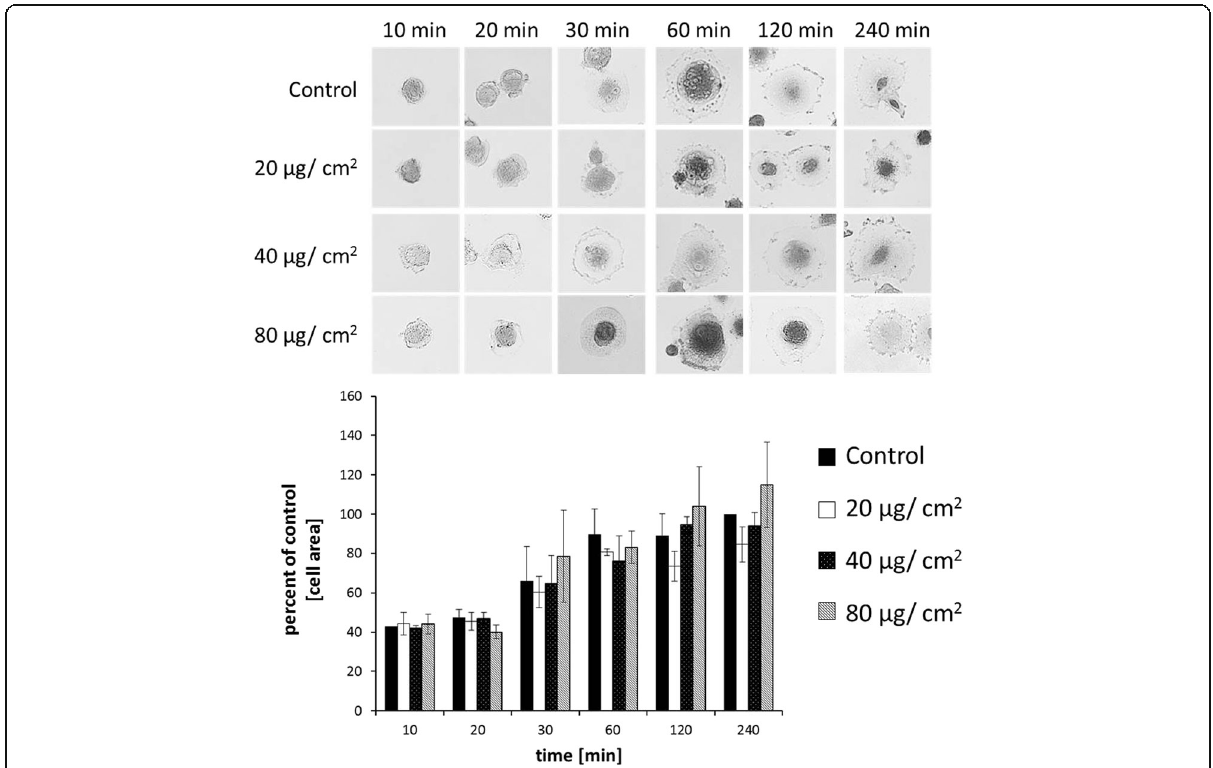
Fig. 2 Spreading of VFF on cell culture plates was not significantly influenced by SPION treatment. Cell spreading was measured by evaluation of cell area ( upper section ). No significant differences were observed between values of control group and each SPION concentration for every time point, respectively ( lower section